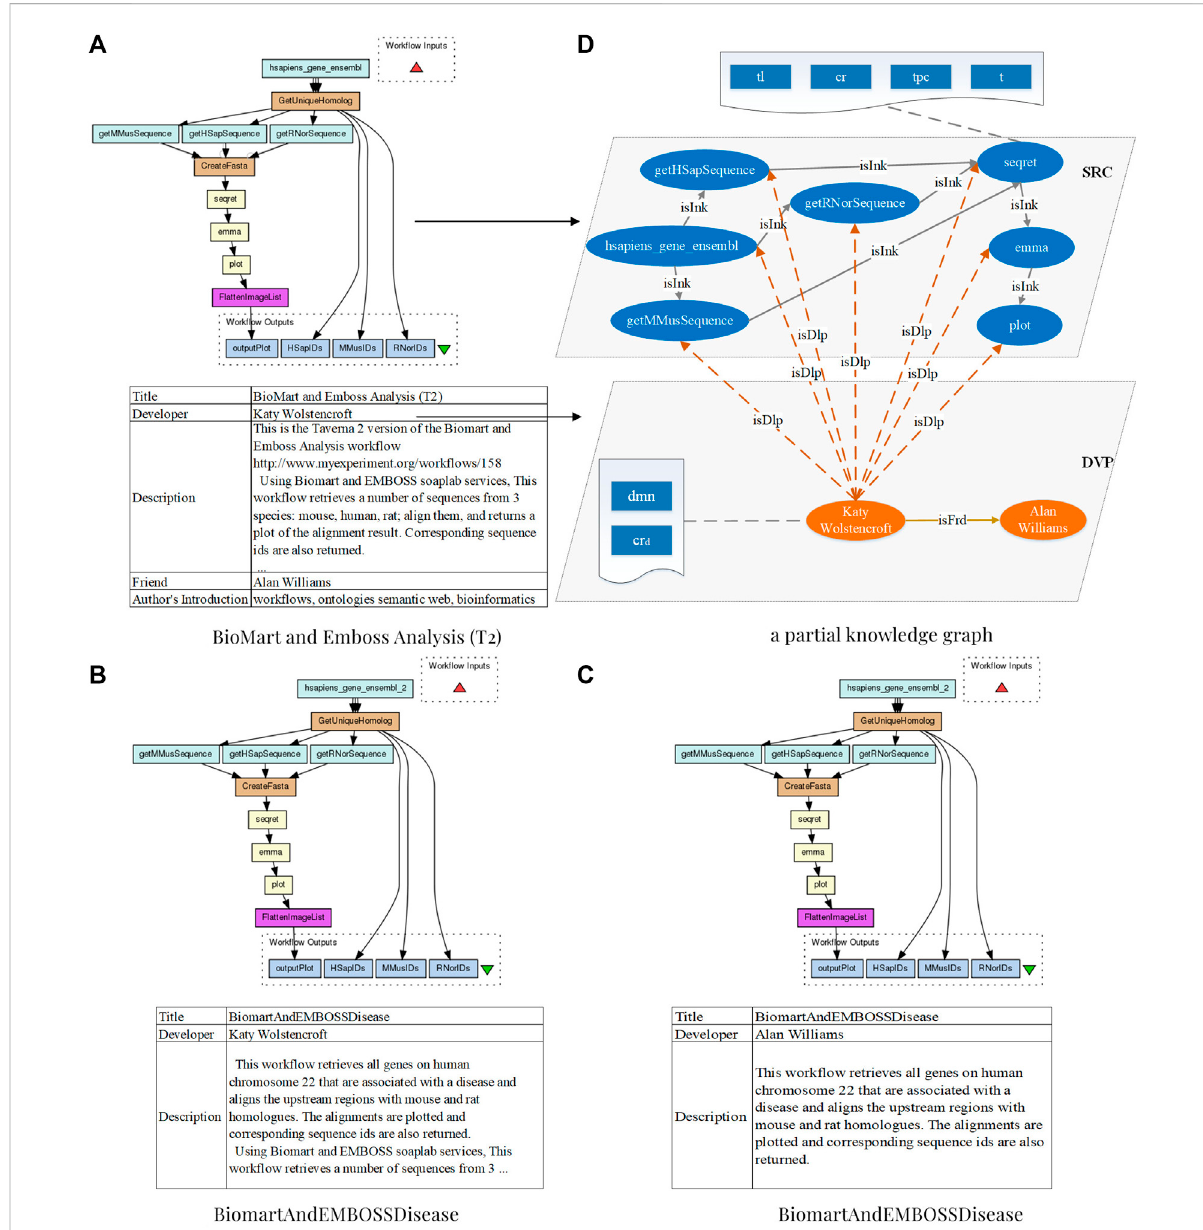
FIGURE 1 Three bioinformatic work fl ows from Taverna 2 of the myExperiment repository with the title “ BioMart and Emboss Analysis (T2) ” , “ BiomartAndEMBOSSDisease ” , and “ BiomartAndEMBOSSDisease ” , respectively, and a partial knowledge graph of the BioMart and Emboss Analysis (T2) in S 2 KG